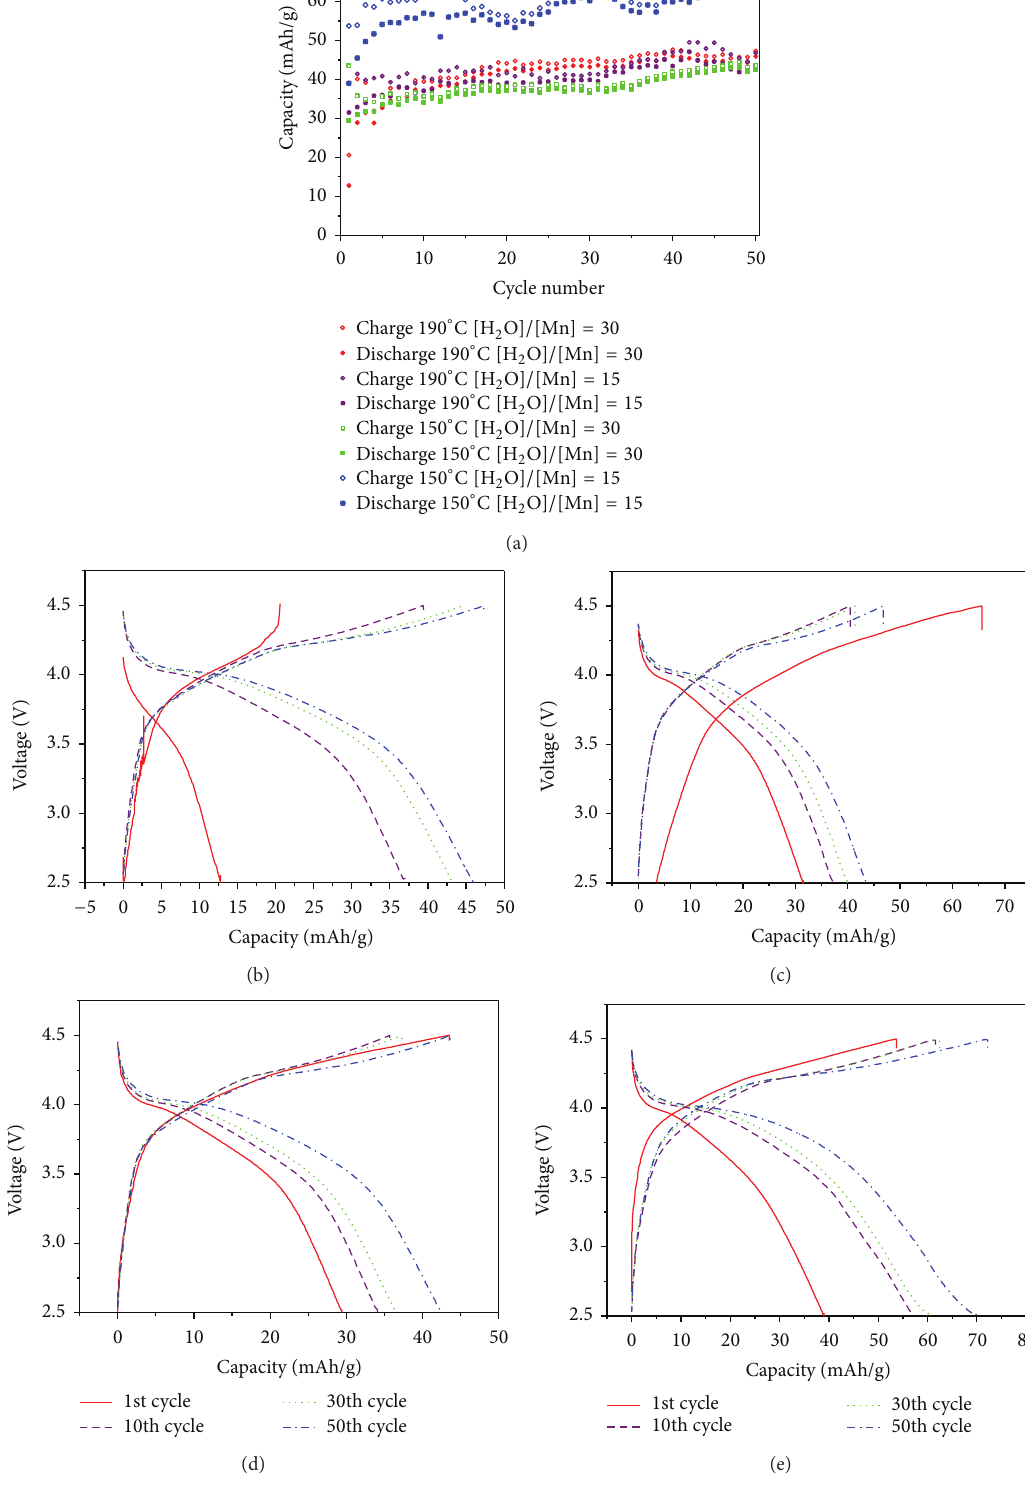
Figure 9: (a) Cycle property of LiMnPO 4 synthesized with various parameters: (b) 190 ∘ C [H 2 O]/[Mn] = 30 (sample B), (c) 190 ∘ C [H 2 O]/[Mn] = 15 (sample E), (d) 150 ∘ C [H 2 O]/[Mn] = 30 (sample F), and (e) 150 ∘ C [H 2 O]/[Mn] = 15 (sample